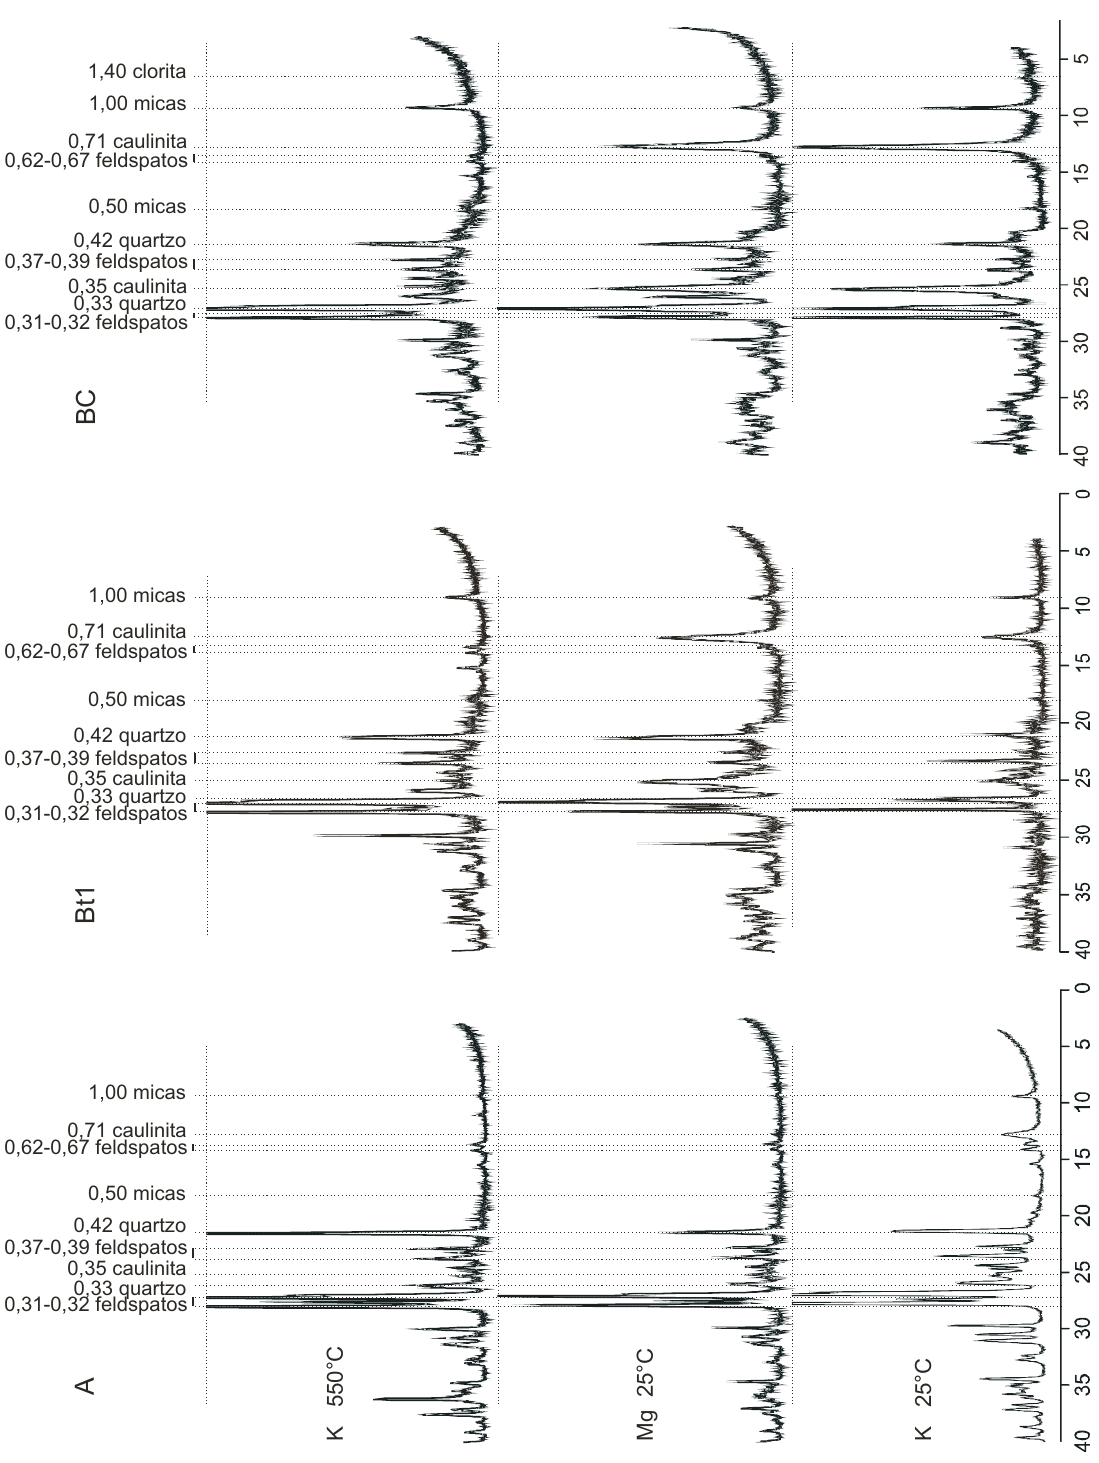
Figura 2. Difratogramas de raios X dos três tratamentos utilizados da fração silte do Argissolo Vermelho- Amarelo (horizontes A, Bt1 e